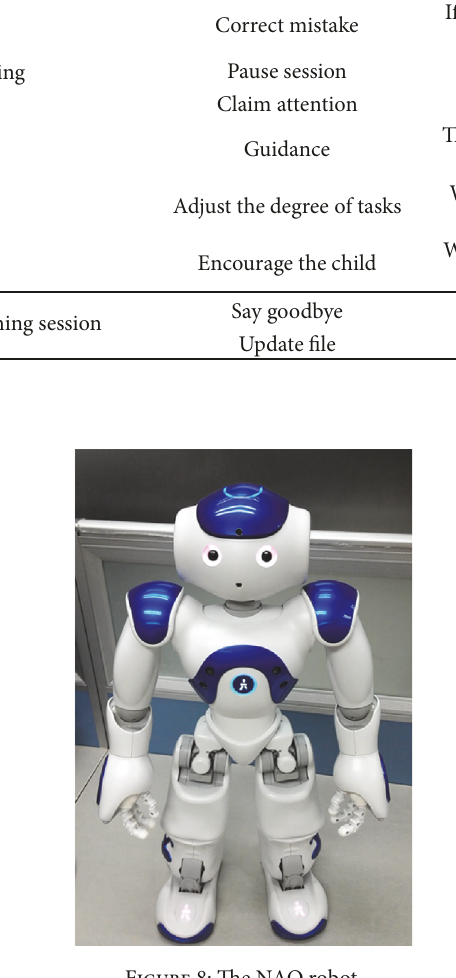
Figure 8: The NAO